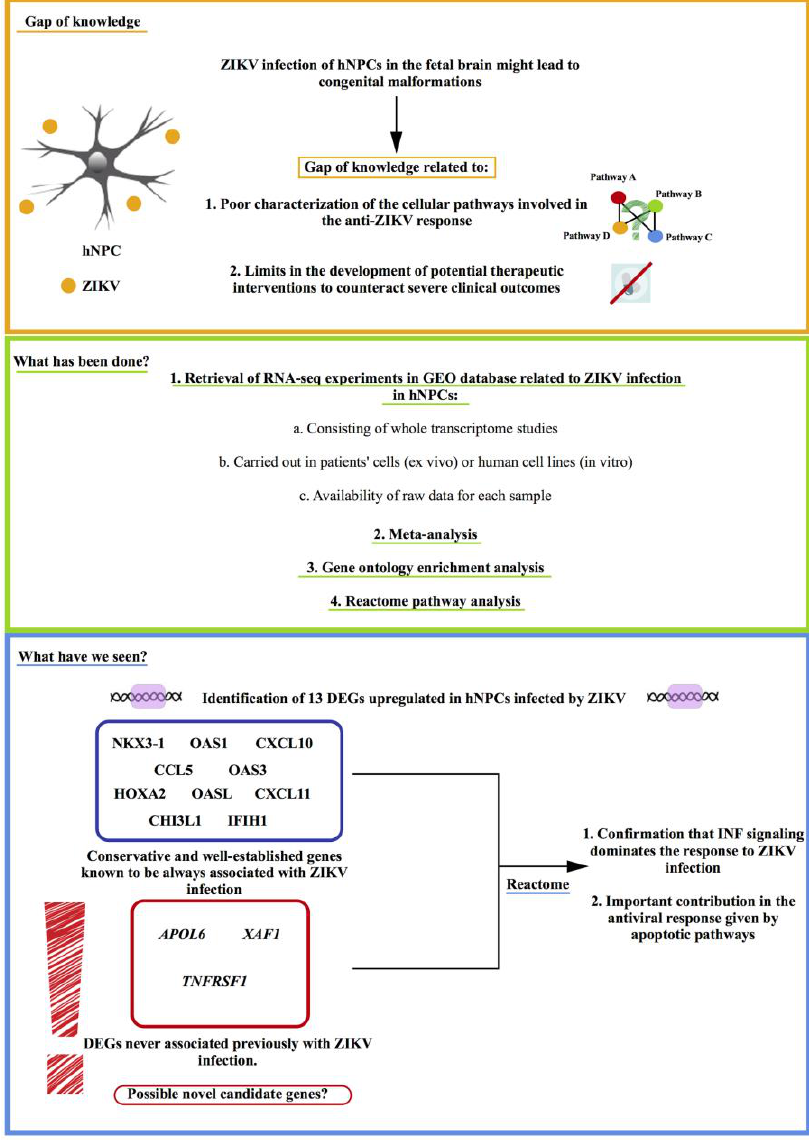
Figure 1. Meta-analysis of RNA-Seq assays for the characterization of congenital Zika syndrome